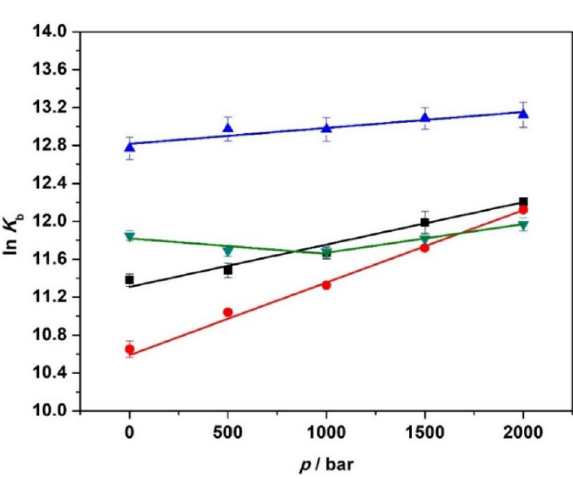
Figure 5. Pressure dependence at T = 25 °C of the natural logarithm of the binding constant, ln K b , in 30 mM Tris pH 7.4 (black squares), in the presence of 60 mM NaCl (red circles), in the presence of 60 mM KCl (blue triangles), and in the presence of 25 wt% Ficoll (green reversed triangles). From the fit of ln K b vs. p, the reaction volume (Δ V r ) can be determined. Where not shown, the error bars are smaller than the symbol